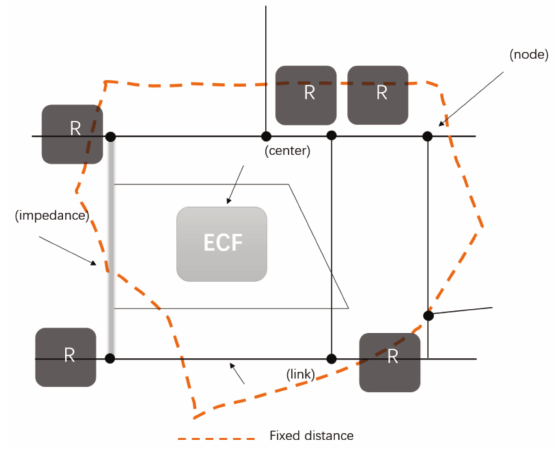
Figure 6. Search radius